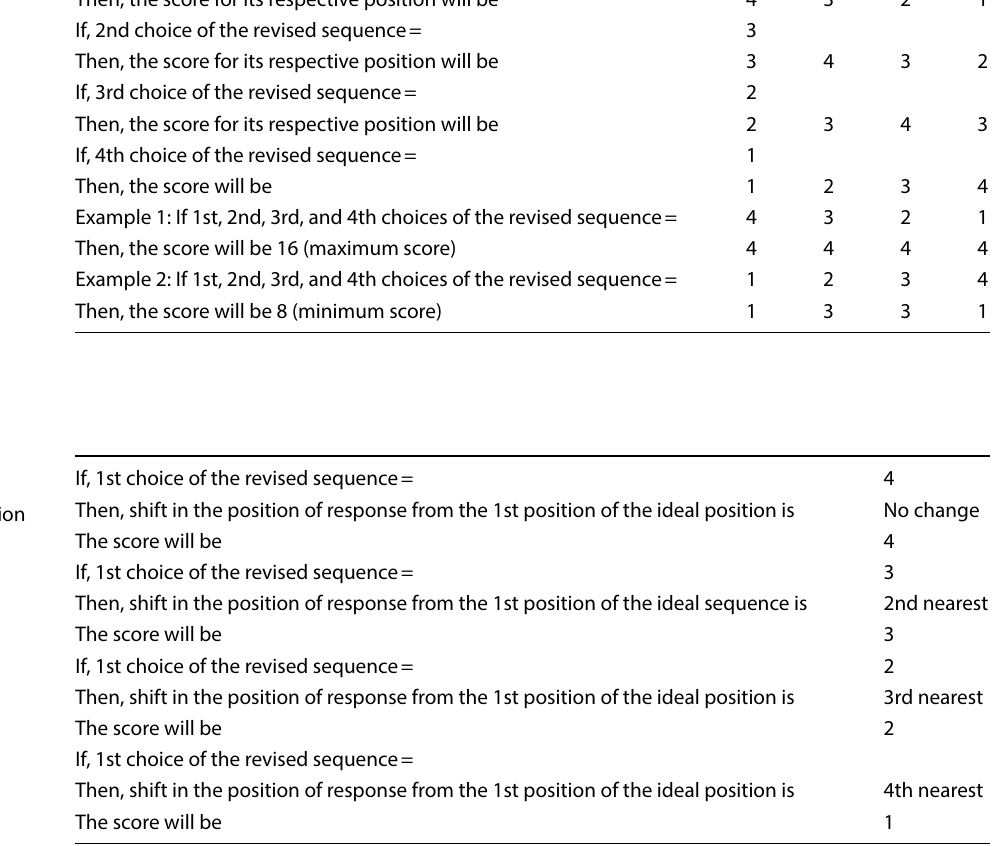
Table 3 Response Score for a shift in the position of response from the ideal position